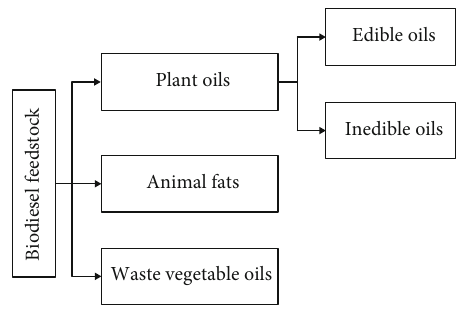
Figure 3: Biodiesel